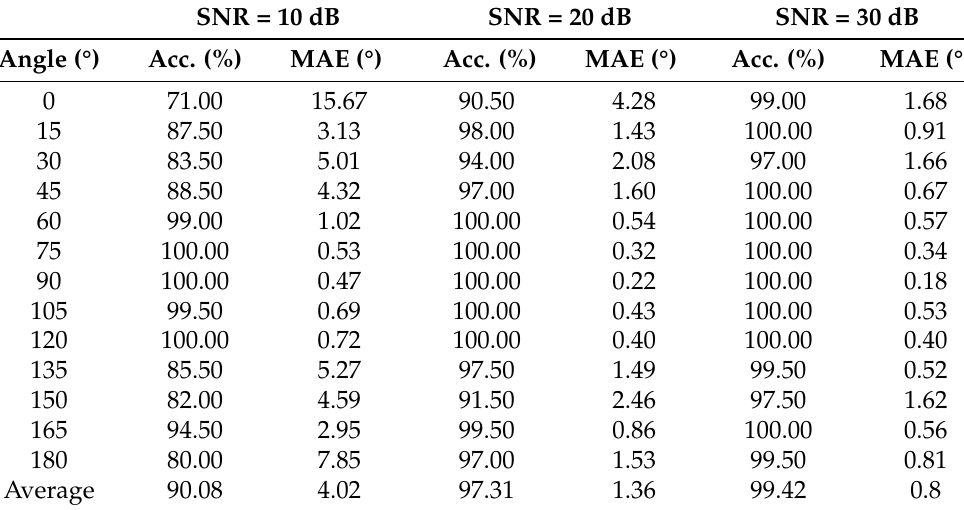
Table 3. Performance of angle estimation by CNN-R in a single acoustic